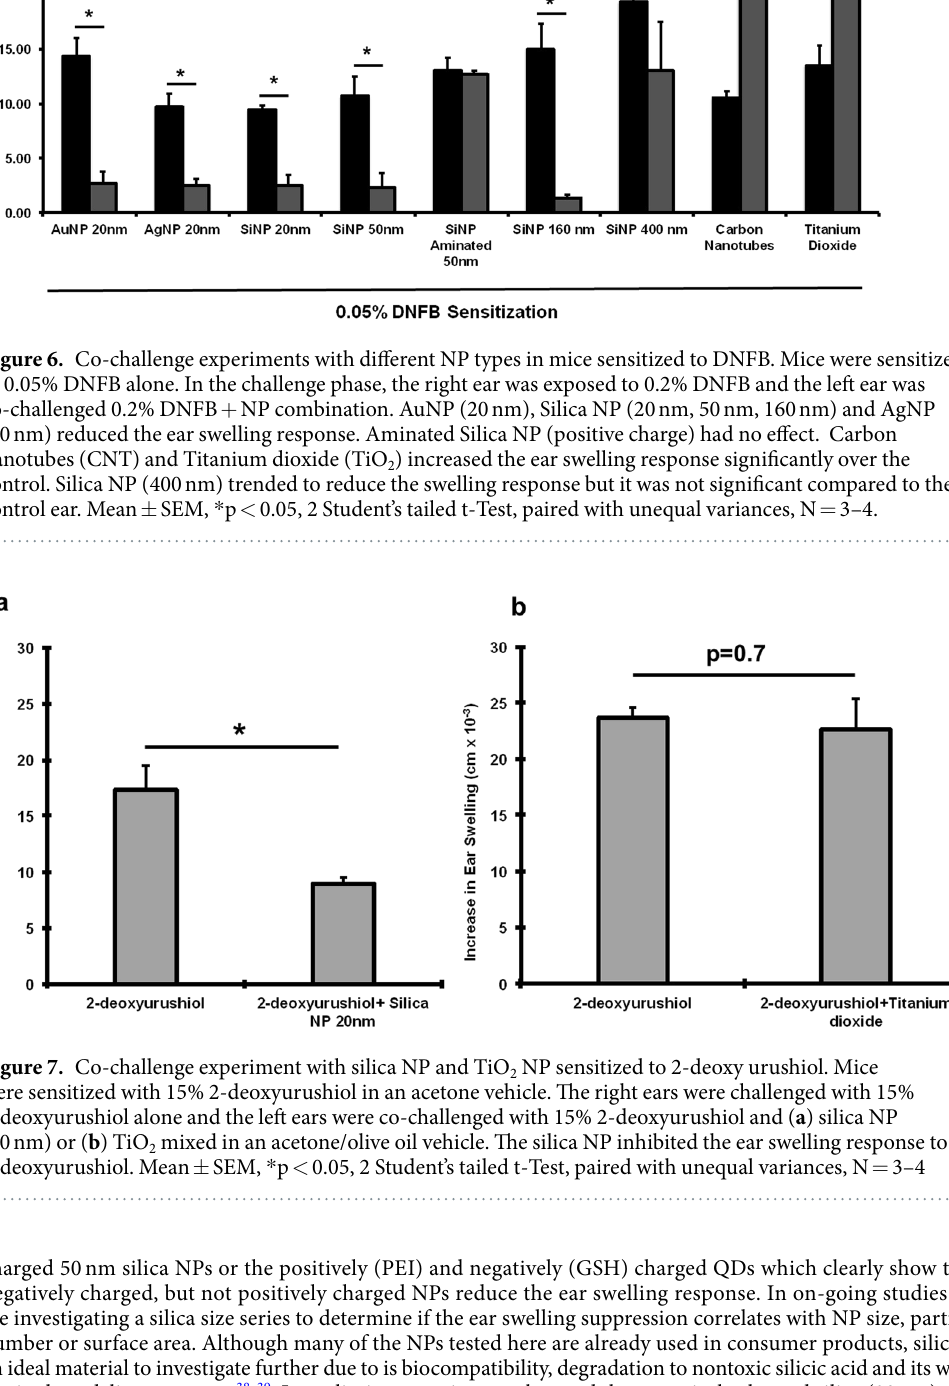
6 Scientific RepoRts | 7: 3979 | DOI:10.1038/s41598-017-03729-2